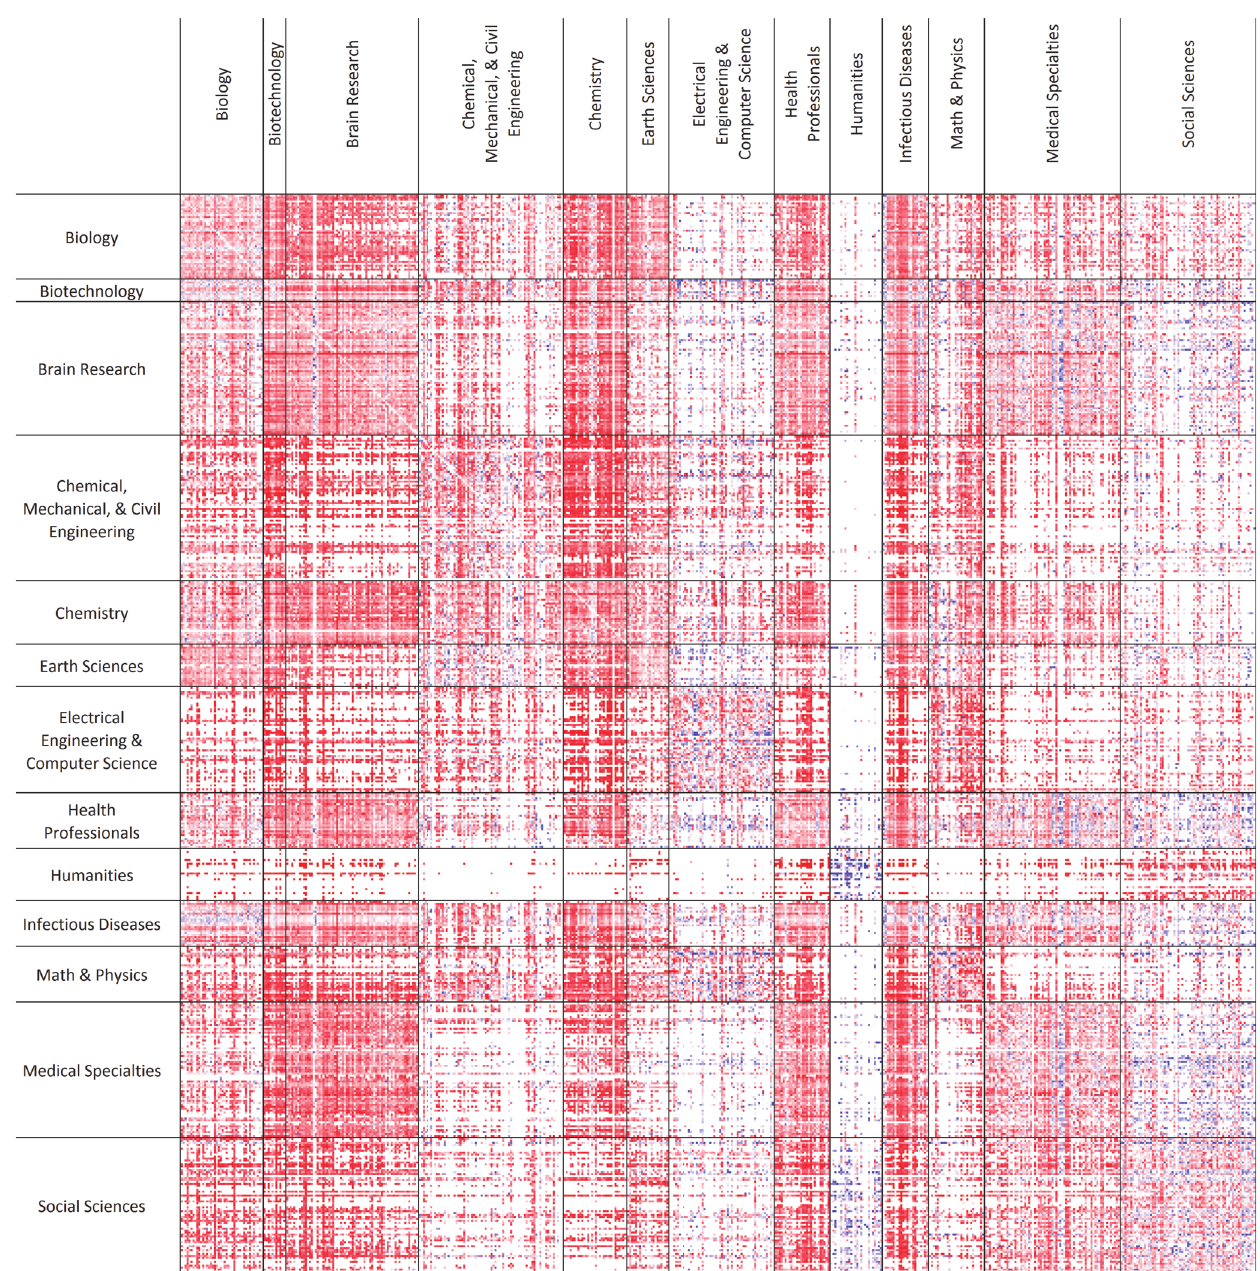
Fig 4. Heat map showing relative citation rates of subdiscipline pairs based on at least 30 co-citing papers, subdisciplines are grouped by superordinate discipline. Cells of subdiscipline pairs below the threshold of 30 co-citing papers and citation rates close to the world average are colored in white, those below in shades of blue (cold) and those above world average in shades of red